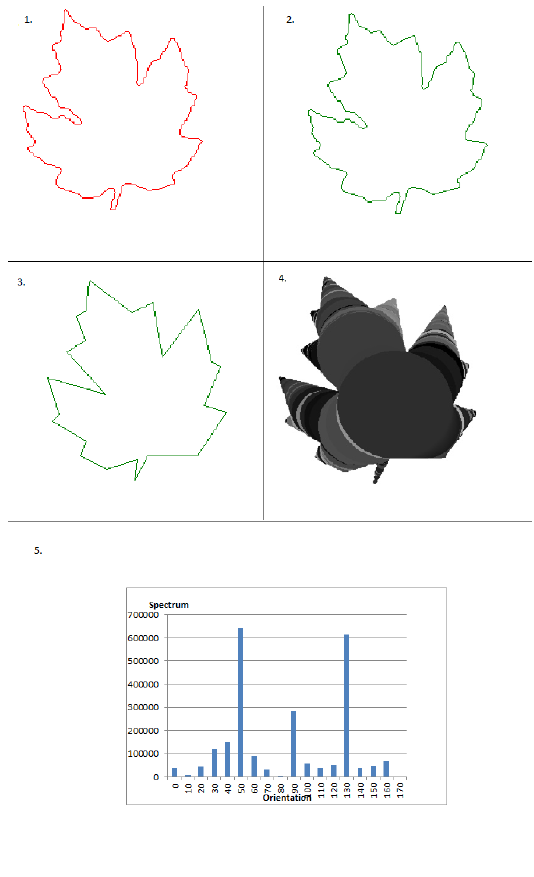
Figure 9: Polygonal contour of the shape: 1. Original polygonal contour; 2. Regularized contour with small regularization coeffi- cient; 3. Regularized contour with big regularization coefficient; 4. Orientation map (orientation coded in color); 5. Orientation spectrum of regularized shape.